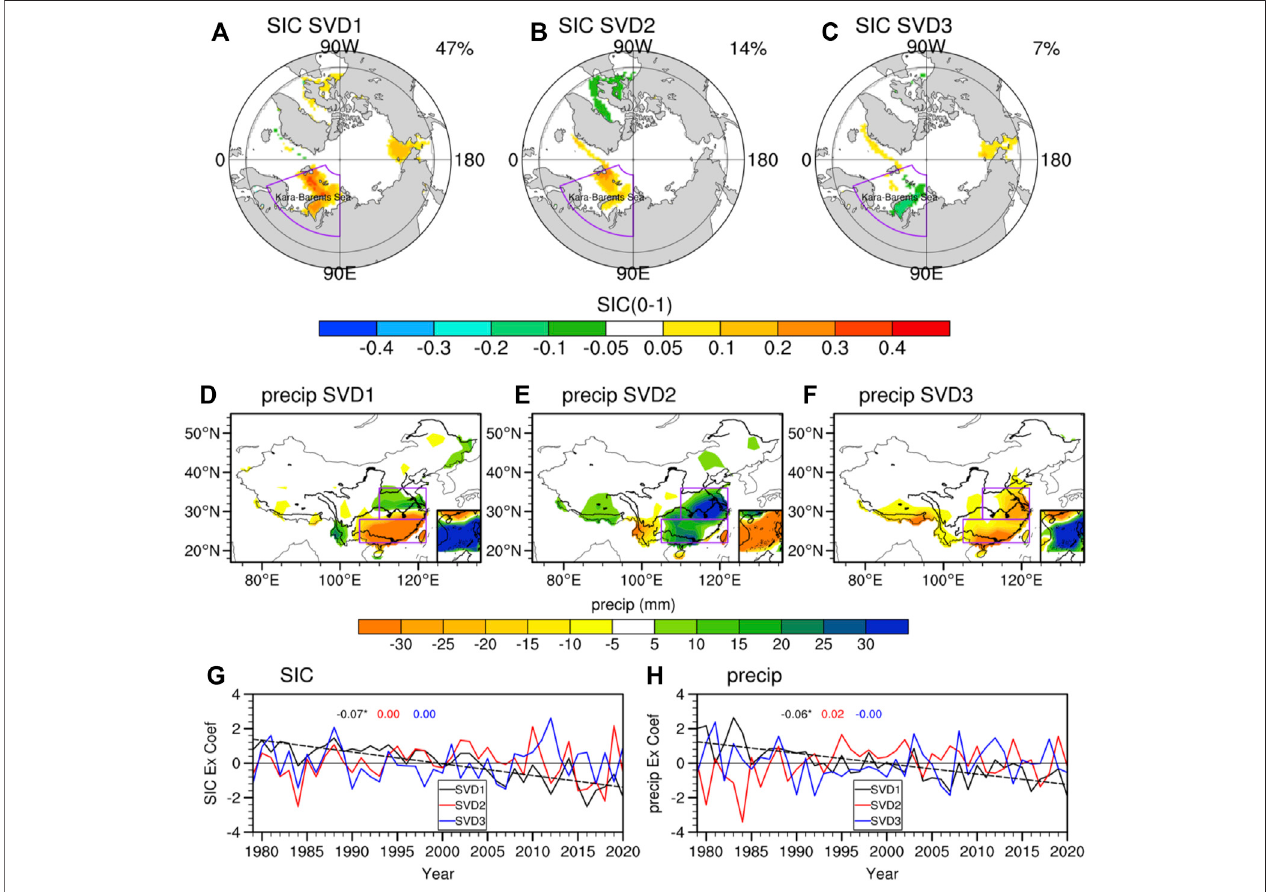
FIGURE 2 | The singular value decomposition (SVD) of the Arctic sea ice cover in November – December and the June precipitation in China mainland (5 – 54 ° N, 72 – 136 ° E). (A – C) Left vectors reconstructed by regressing the Arctic sea ice cover against the standardized expansion coef fi cient of the left homogeneous fi eld. The percent covariance explained by the SVD modes is printed on the top right for each plot. (D – F) Right vectors reconstructed by regressing the June rainfall anomalies against the standardized expansion coef fi cient of the right homogeneous fi eld. The purple boxes show the relatively large rainfall variability centers (28 – 36 ° N, 110 – 122 ° E and 22 – 28 ° N, 105 – 122 ° E). (G,H) Standardized expansion coef fi cients of the left and right homogeneous fi elds. The trend for each expansion coef fi cient is also printed with the same color as for the curve. An asterisk is added if the trend is signi fi cant at the 95% con fi dence